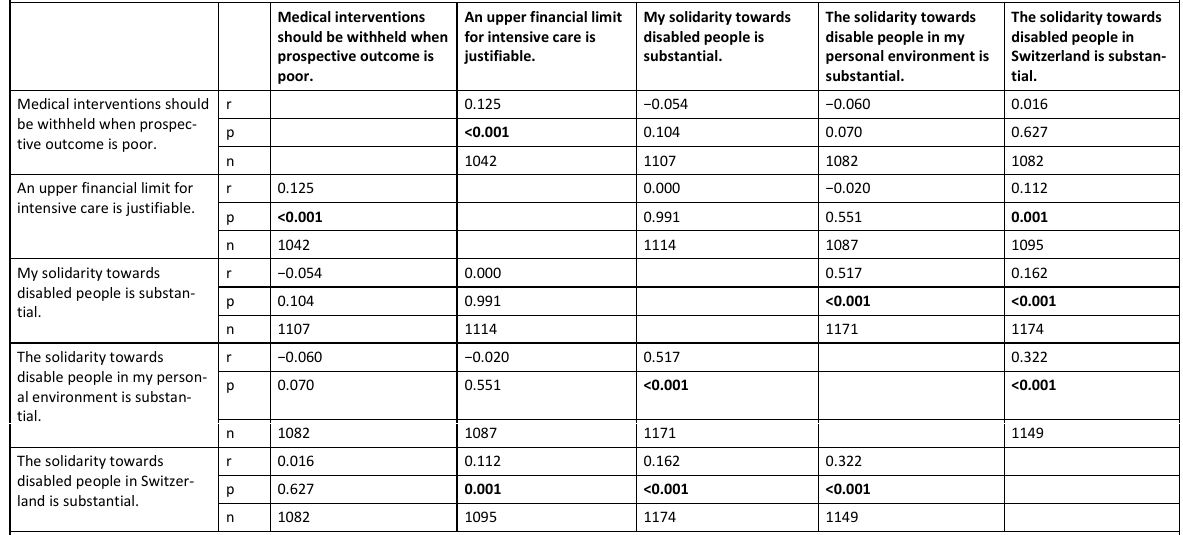
Table 2: Correlations between withholding treatment, setting an upper financial limit, and solidarity.